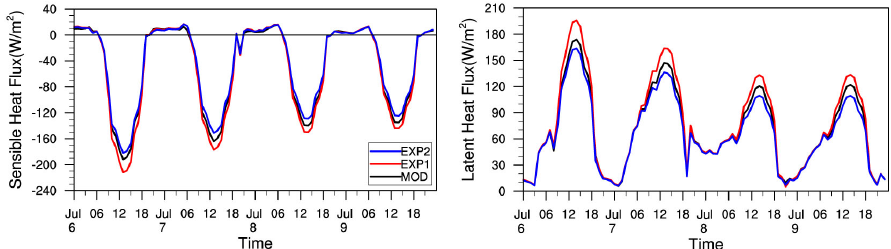
Fig. 5. The difference of sensible and latent heat fluxes between the oasis and the desert in a time series from the MOD, EXP1 and EXP2 simulations (the difference was calculated by subtracting the average heat flux over the desert from the average heat flux over the oasis).